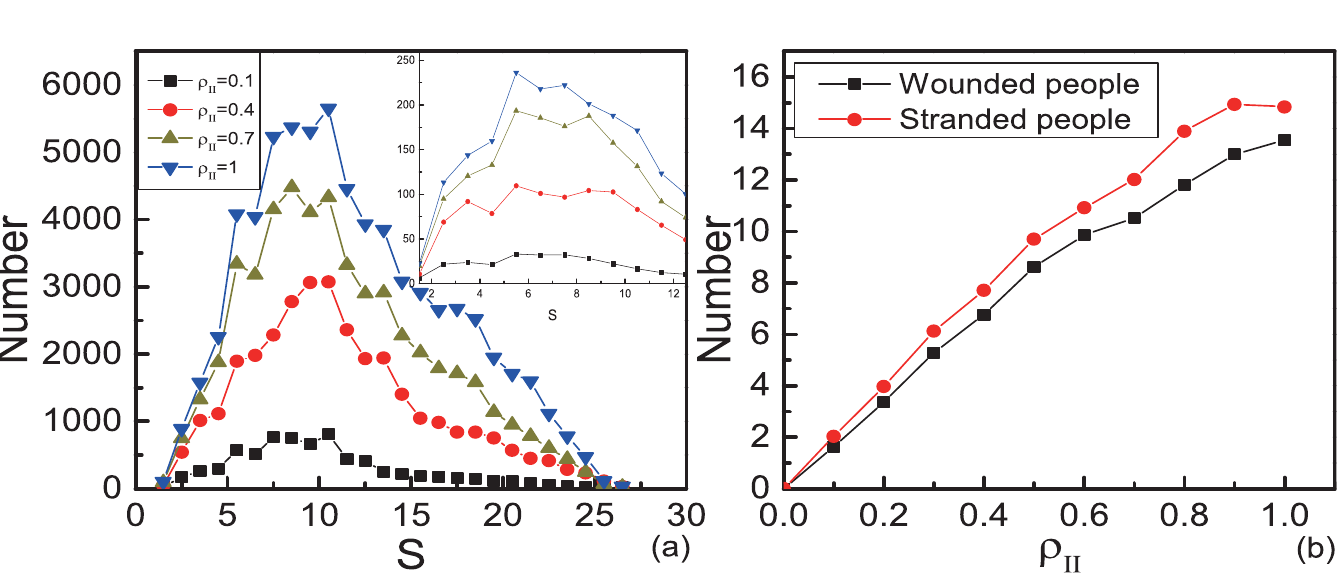
Fig 5. Number of wounded and stranded people with fixed motion mode. Here, p w , I = 0.001 and p w , II = 0.0001. (a)The distribution of the distances from wounded people to the exit. The inset graph displays the distribution of the number of wounded people per unit area. The horizontal ordinate of every points S is the median of internal [ S − 0.5, S + 0.5]. The data are obtained by 5000 different realizations. (b)The numbers of wounded people and stranded people as functions of ρ II . The data points are obtained by averaging over 500 different